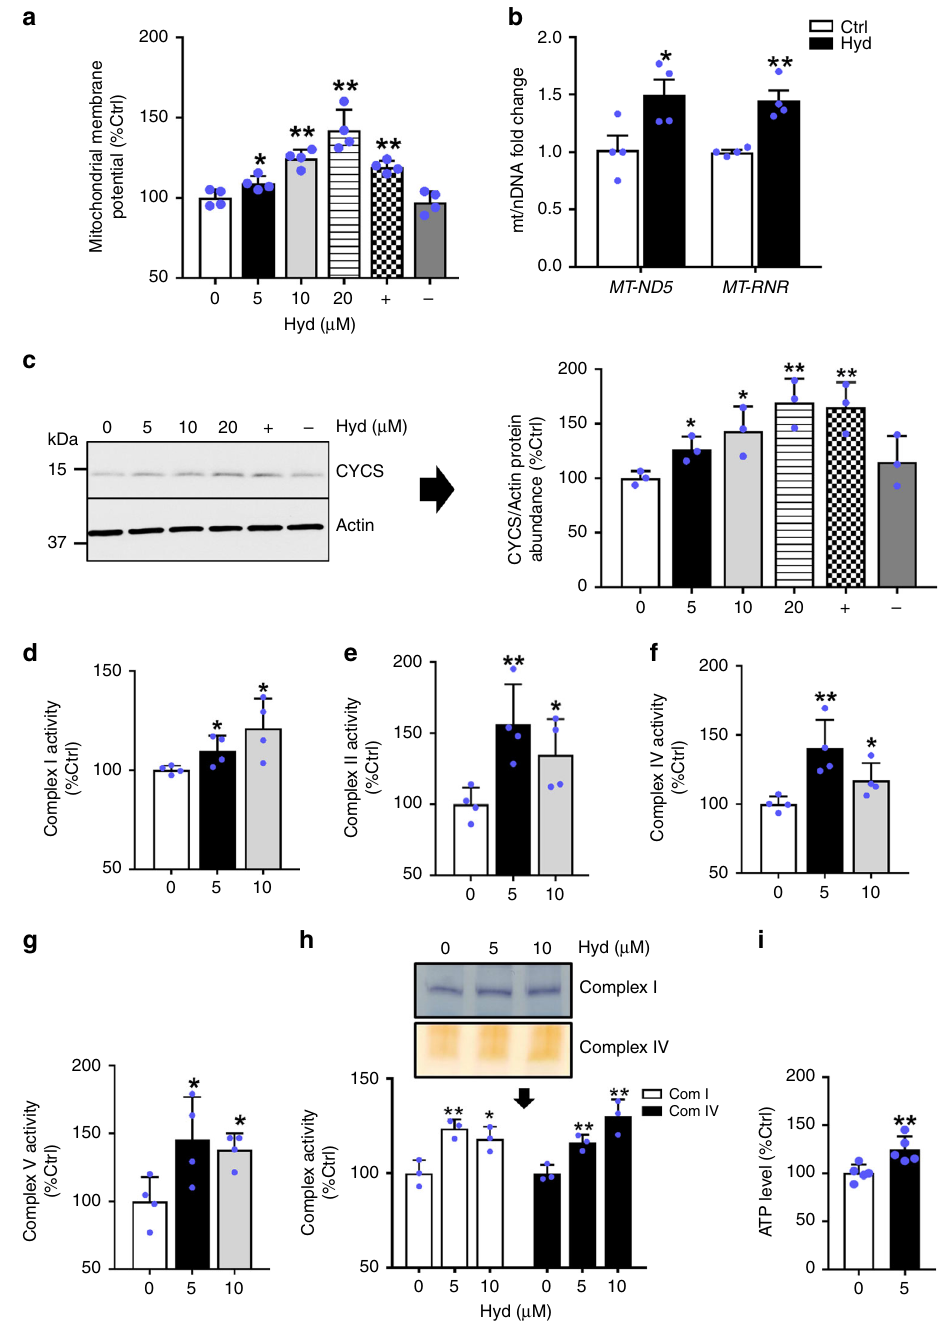
Fig. 1 Hydralazine improves mitochondrial function. a ΔΨ m was measured in SH-SY5Y cells treated with different concentrations of hydralazine for 72 h. 10 µ M isoniazid or resveratrol were used as negative and positive controls ( n = 4, mean ± SD). b Relative q-PCR analysis of mitochondrial DNA showing an increased mt/nDNA in SH-SY5Y cells treated with hydralazine (5 µ M) for 72 h ( n = 4, mean ± SEM). c Hydralazine increases cytochrome c (CYCS) abundance in a dose-dependent manner measured by Western blot analysis in SH-SY5Y cells ( n = 3, mean ± SD). Spectrophotometric analysis of mitochondrial complexes showing activation of ETC d complex I, e complex II, f complex IV and g ATP synthase complex V in C2C12 cells treated with hydralazine for three days ( n = 4, mean ± SD). h In-gel activity assay of the isolated mitochondria showing higher activity for mitochondrial ETC complexes I and IV in C2C12 treated with hydralazine for 72 h ( n = 3, mean ± SD). i The relative amount of ATP in SHY-SY5Y cells treated with 5 µ M hydralazine for 72 h ( n = 5, mean ± SD). *p ≤ 0.05 and **p ≤ 0.01, two-tailed Student ’ s t